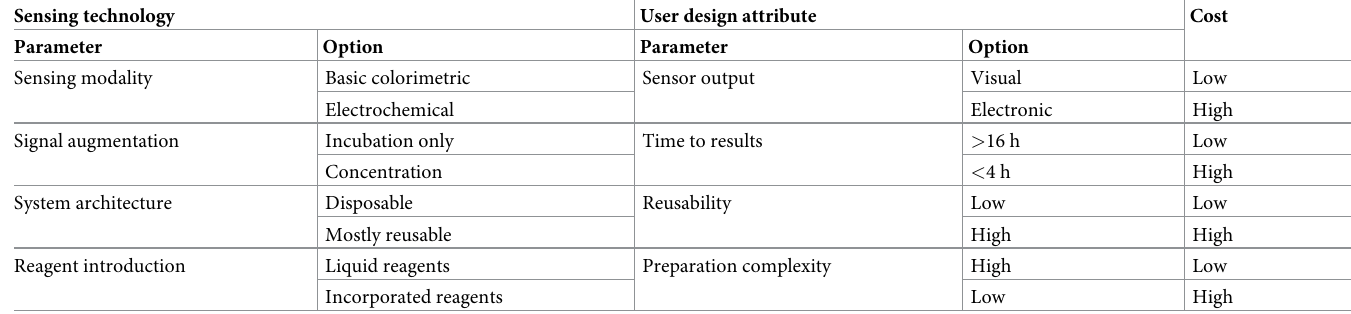
Table 1. Translation of sensing technology options to corresponding design attributes as perceived by users, along with the relative cost of each option. Sensing